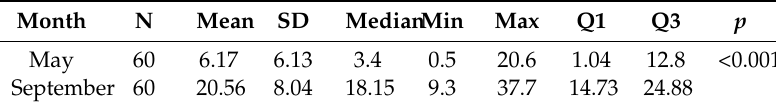
Figure 4. Dependence of canopy water storage capacity from the month of sampling; V, samples taken in May; IX, samples taken in September. Table 3. Analysis of the influence of the leaf sampling time on S (g/g).